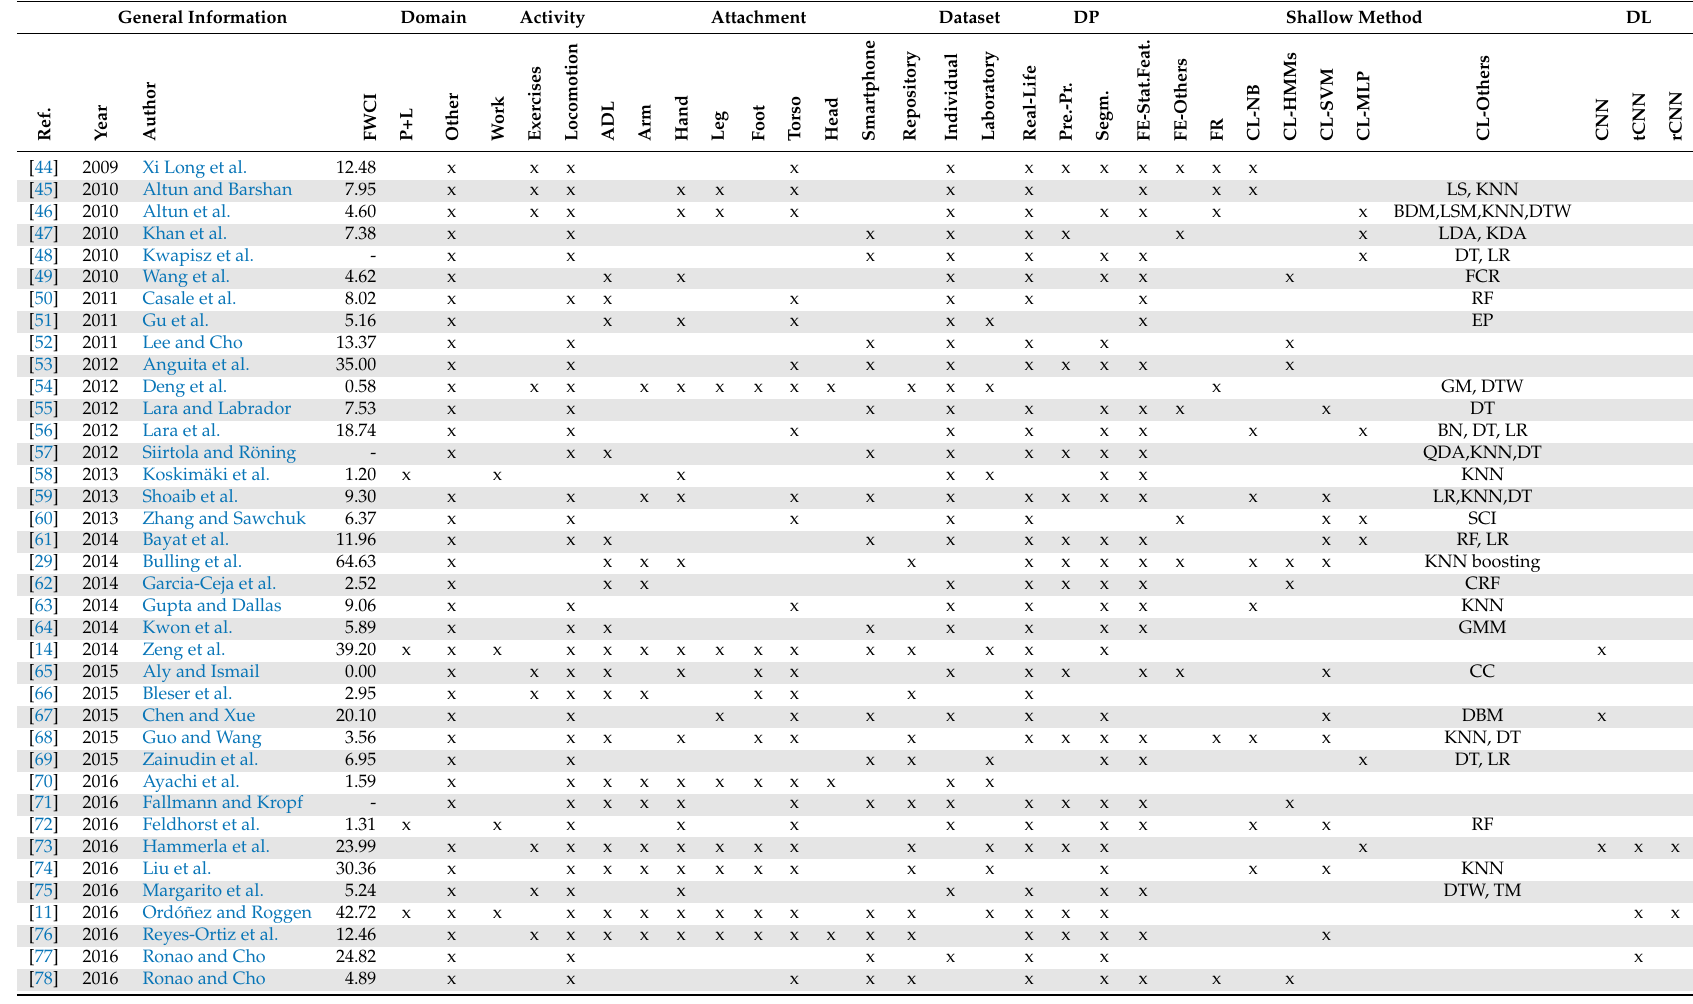
Table 7. Systematic Review of relevant literature (Stage